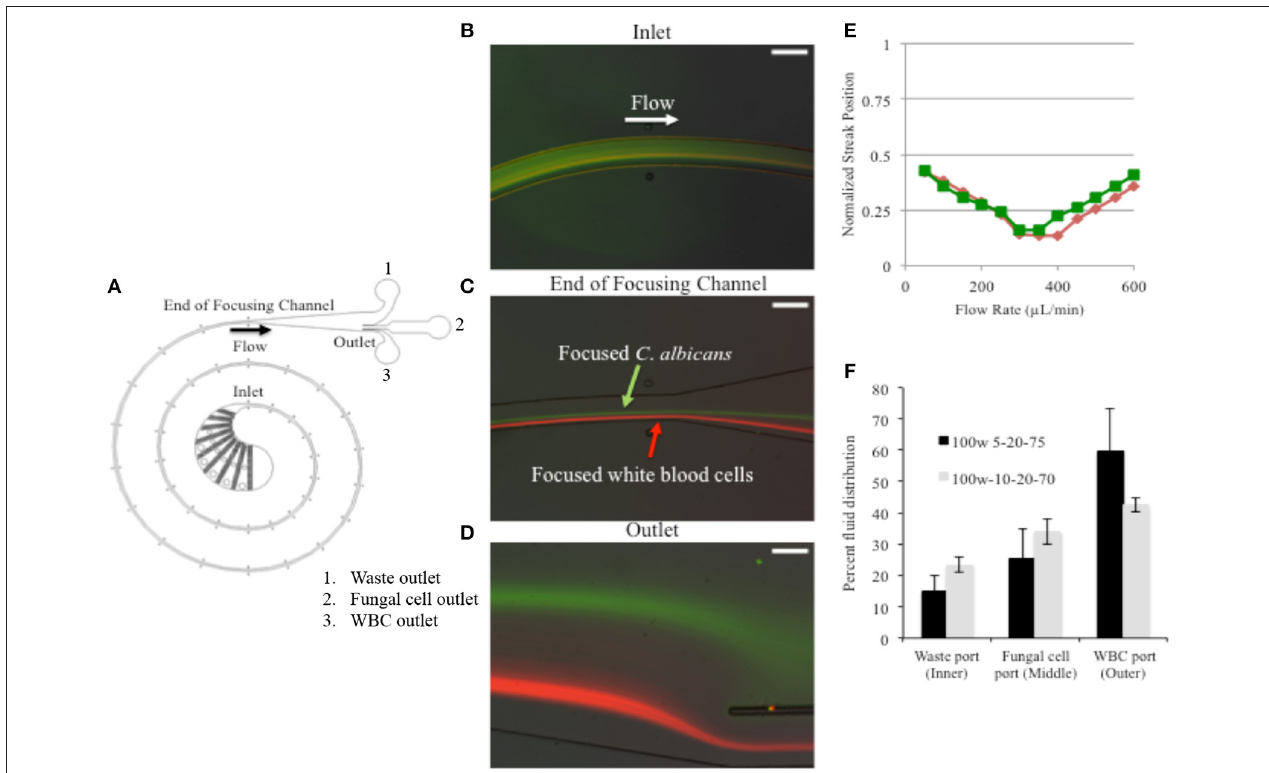
FIGURE 1 | Fungal cells were FITC stained to differentiate from calcein stained WBCs. (A) Device schematic. (B) A mixture of cells that includes stained WBCs and fungal cells enters the IFF without prior separation and are subjected to the microfluidic forces and specified flow rate. (C) As cells travel through the path of the coil, at a specific flow rate of 400 µ L/min, C . albicans are focused into a stream. (D) By the time they reach the outlet, the cell form two distinct streams. (E) The lateral separation of cell types was tested over a range to detect the optimal applied flow rate. (F) The distribution observed at device 100w-5-20-75 is shown in black and distribution for IFF device design 100w-10-20-70 is shown in gray. Error bars indicated standard deviation.